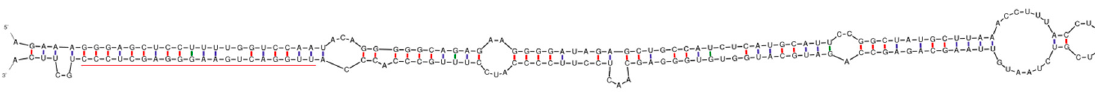
Figure 6. Mature and predicted fold-back structures of miR319 precursors in G. hirsutum . Sequences of mature miR319 are underlined.